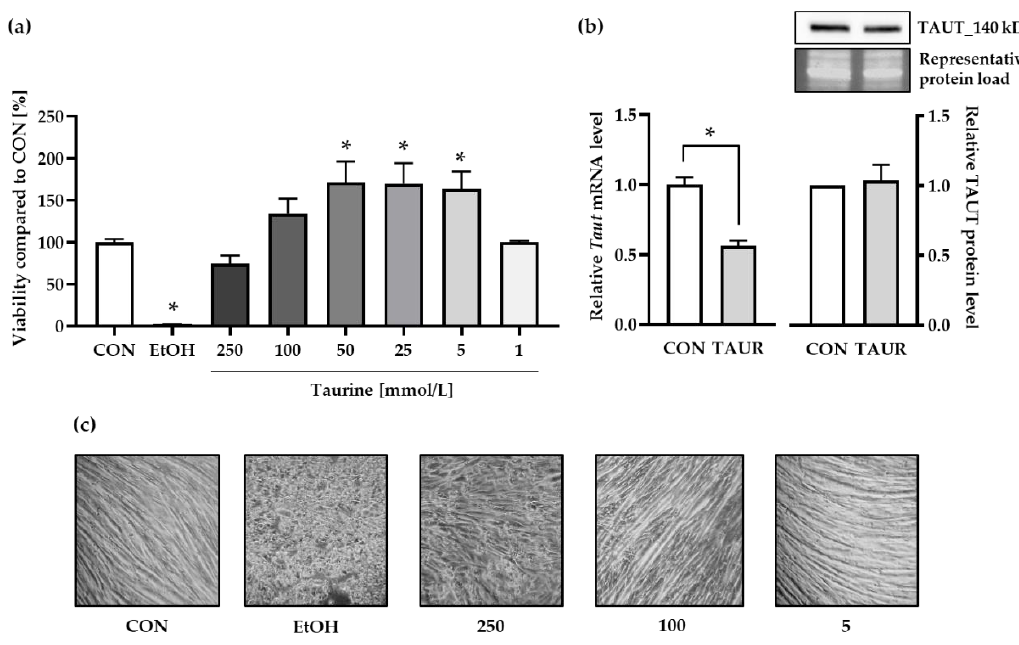
Figure 1. Taurine (TAUR) was not cytotoxic at concentrations of up to 100 mmol/L ( a ) Cell viability after 24 h was determined by the uptake of neutral red by taurine-supplemented (1–250 mmol/L) myotubes and untreated control (CON) myotubes. Ethanol (10%) was used as the positive control to induce cytotoxicity. The data are shown as the means + SEM ( n = 6–9). ( b ) Compared to CON, TAUR decreased the mRNA levels of the taurine transporter (TAUT), but TAUT protein levels remained unchanged. TAUT protein levels were quantified densitometrically and normalized according to total protein per lane. A representative section of the target bands and corresponding total protein bands visualized by UV are shown. ( c ) Optical microscopy images (200×) of differentiated myotubes show morphological changes and cell fragmentation induced by treatment with EtOH and the highest taurine concentration (250 mmol/L), whereas cells incubated with 5 mmol/L taurine did not differ from CON cells. The data are shown as the means + SEM ( n = 3 for taurine and TAUT analysis; n = 6 for Taut mRNA experiments). * Indicates significant differences compared to CON; p < 0.05.